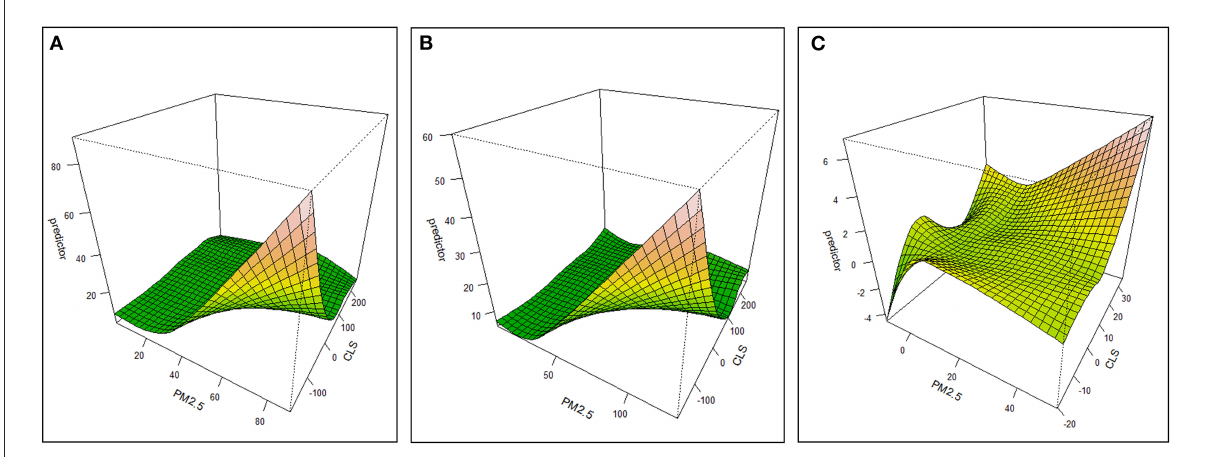
FIGURE4 Three-dimensional effect graph of PM 2.5 -CLS interaction on the variation of mortality (A) 2000 (B) 2010 (C) 2010–2000.